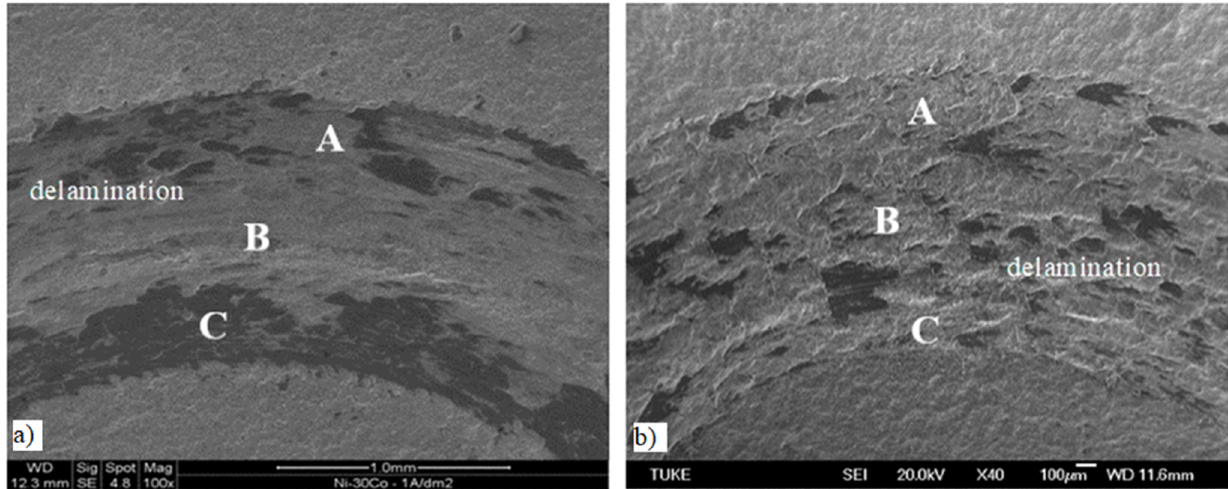
Figure 12. The worn surface of Ni-Co coatings: ( a ) Sample 3; ( b ) Sample 4. The A, B, and C places mark the EDX analysis locations. Table 4. Quantitative EDX analysis of element content in the area tribo track on Ni-Co coatings in wt. % after tribological test at the temperature of 400 ◦ C at the listed current density.